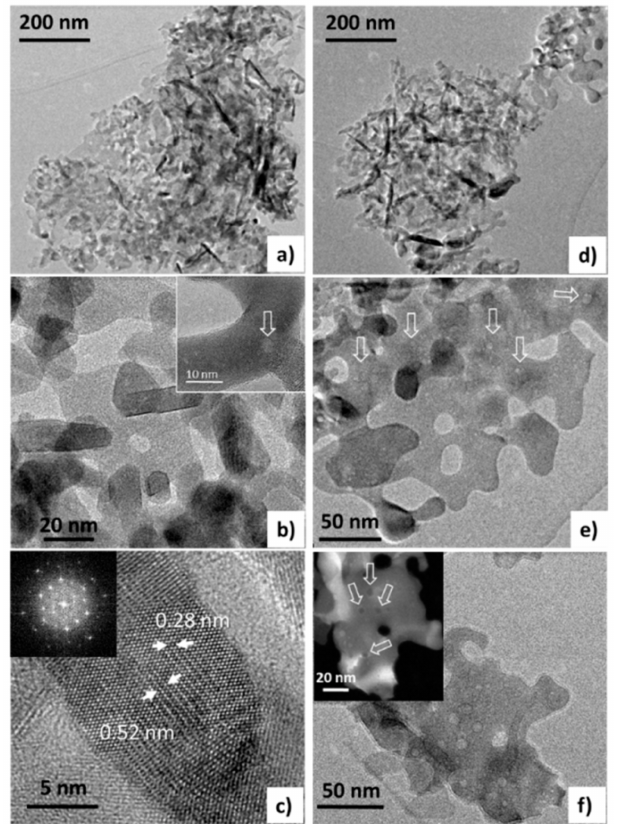
Figure 8. HRTEM images at different magnifications of the Fe-ST2 catalyst ( a – c ) before use and ( d – f ) after three catalytic cycles. Unfilled arrows indicate nanocavities. Insets: in ( c ) fast Fourier transform (FFT) coherent with indicated distances, which correspond to (111) and (220) interplanar distances of spinel structure; in ( f ) corresponding Scanning Transmission Electron Microscopy (STEM) image, in which nanocavities are clearly appreciated as black